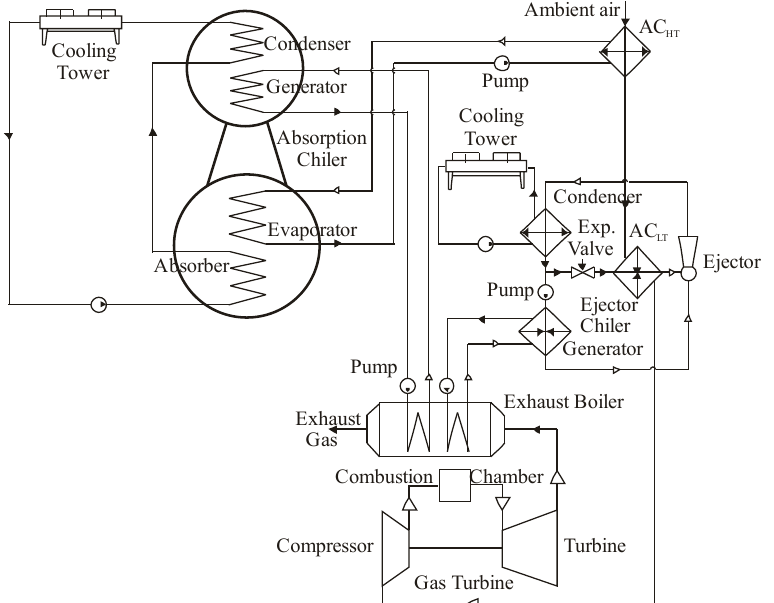
Figure 3. A circuit of hybrid two-stage TIAC system in AECh with ACh as high temperature and ECh as low temperature stages: AC HT and AC LT —high and low temperature stages of air cooler; Exp. Valve—expansion valve.